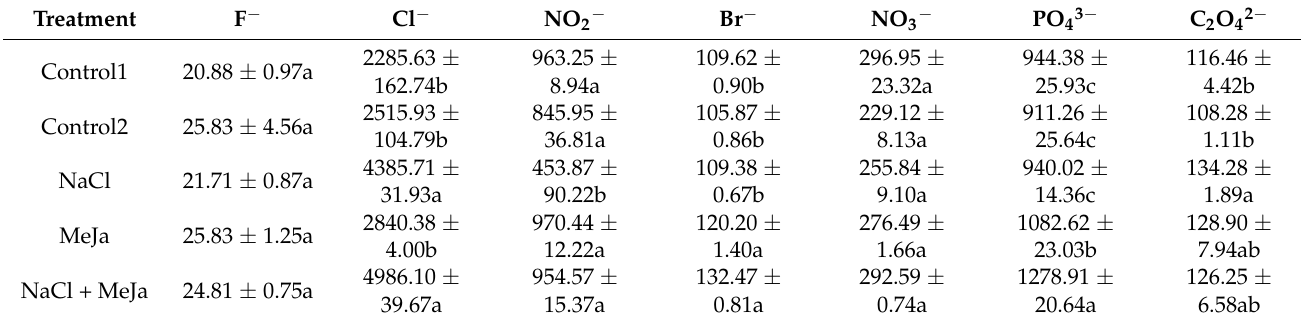
Table 3. The content of anions (F − , Cl − , NO 2 − , Br − , NO 3 − , PO 43 − , C 2 O 42 − ) (mg kg − 1 FW) in the leaf tissues of C. maritimum under the different treatments (Control1, Control2, NaCl, MeJa, NaCl + MeJa), ( n = 10). Columns with different letters (a, b, c) for each variable differ significantly according to Tukey’s test ( p < 0.05). Treatment